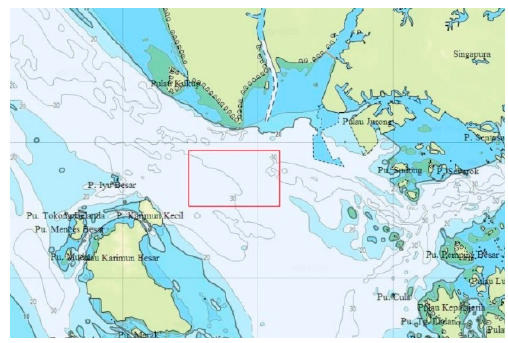
Figure 6. Selected water area-1 [44,45].